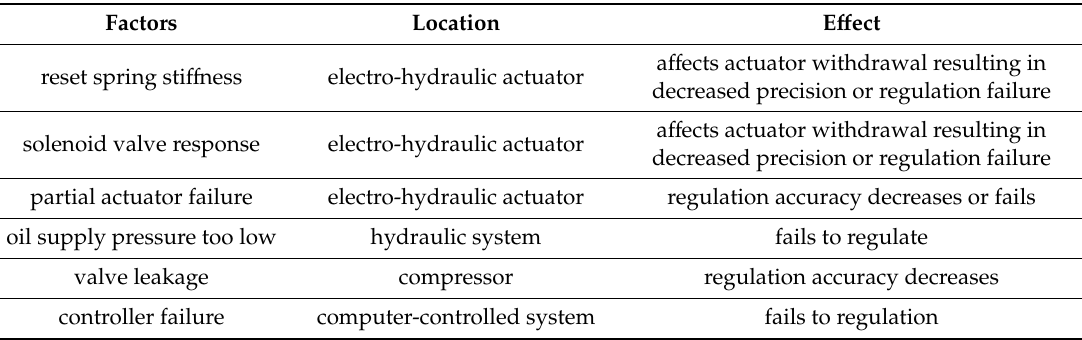
Table 1. The main factors that a ff ect the regulation performance.